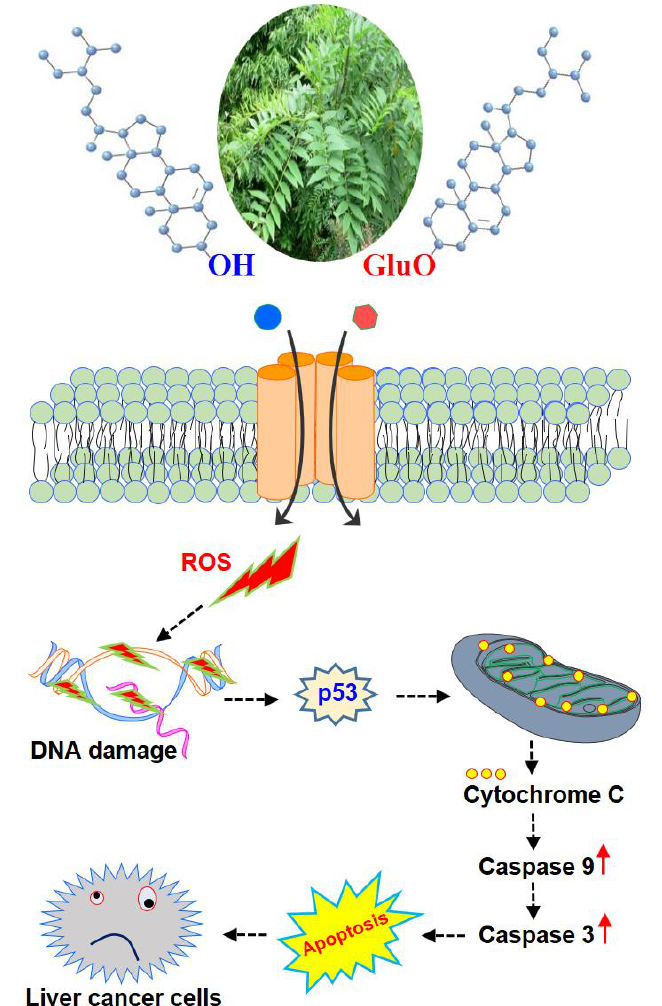
Figure 9. Schematic representation of the proposed signaling effect of β-S and β-SG on liver cancer cells. β-S and β-SG induce excessive ROS production through caspase-dependent pathways. ROS accumulation causes DNA damage, p53 activation, and triggers the mitochondrial-mediated apoptotic cell death in HepG2 and Huh7 cells.